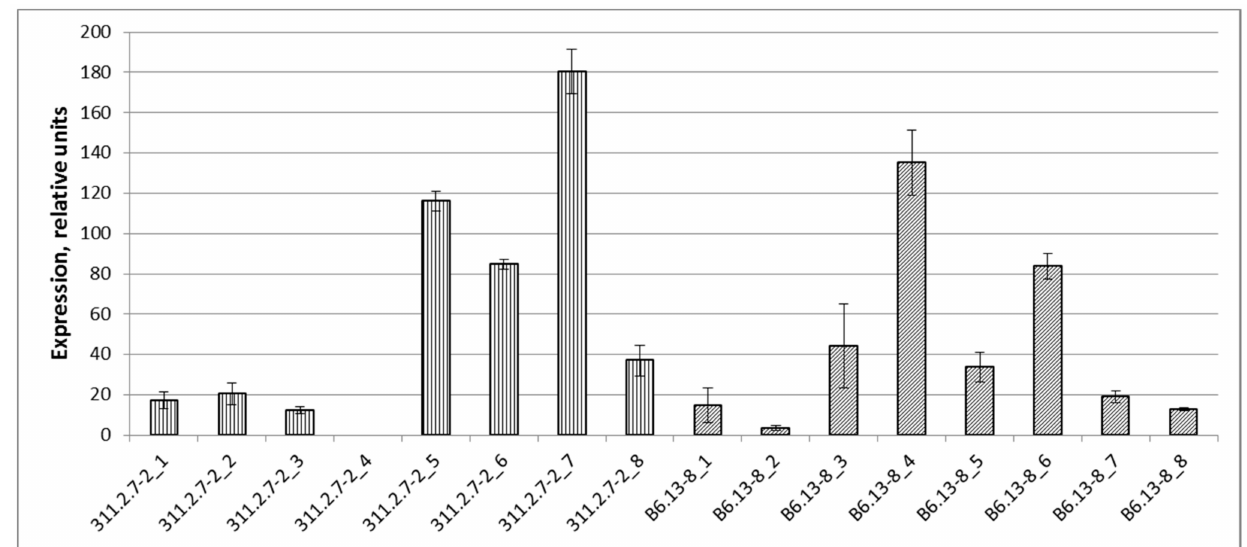
Figure 2. sIFNG gene expression in green tissues of individual tobacco plants, lines 311 and b6. Each sample was tested in three technical replicates. Error bars represent standard deviation.